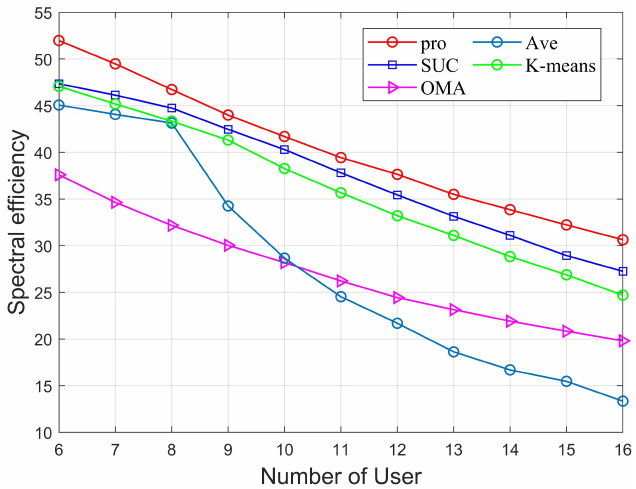
Figure 6. SE versus P tol of different algorithms.